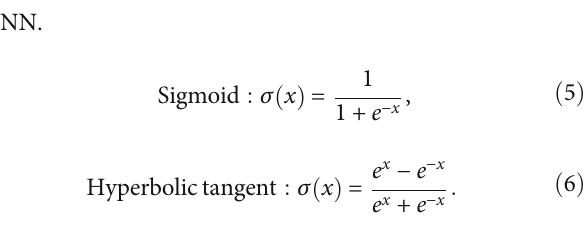
Figure 8: Experimental results of fracture plugging with di ff erent penetration